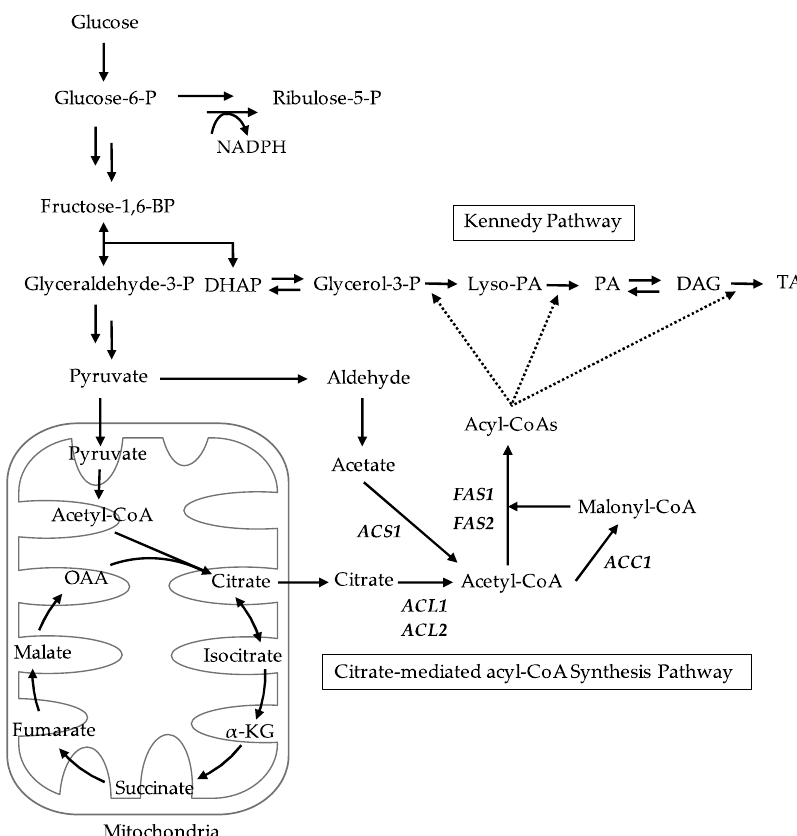
Figure 3. Overview of the principal metabolic pathways for TAG synthesis in L. starkeyi. Abbrevia- tions for genes and metabolites are indicated as follows: ACC1 , acetyl-CoA carboxylase; ACL1 / ACL2 , ATP-citrate lyase; ACS1 , acetyl-CoA synthetase; α -KG, α -ketoglutarate; DAG, diacylglycerol; DHAP, dihydroxyacetone phosphate; FAS1 / FAS2 , fatty acid synthase subunit; Fructose-1,6-BP, fructose-1,6-bisphosphatase; Glucose-6-P, glucose-6-phosphate; Glyceraldehyde-3-P, glyceraldehyde-3-phosphate; Glycerol-3-P, glycerol-3-phosphate; Lyso-PA, lysophosphatidic acid; NADPH, reduced nicotinamide adenine dinucleotide phosphate; OAA, oxaloacetate; PA, phosphatidic acid; Ribulose-5-P, ribulose-5- phosphate; TAG,